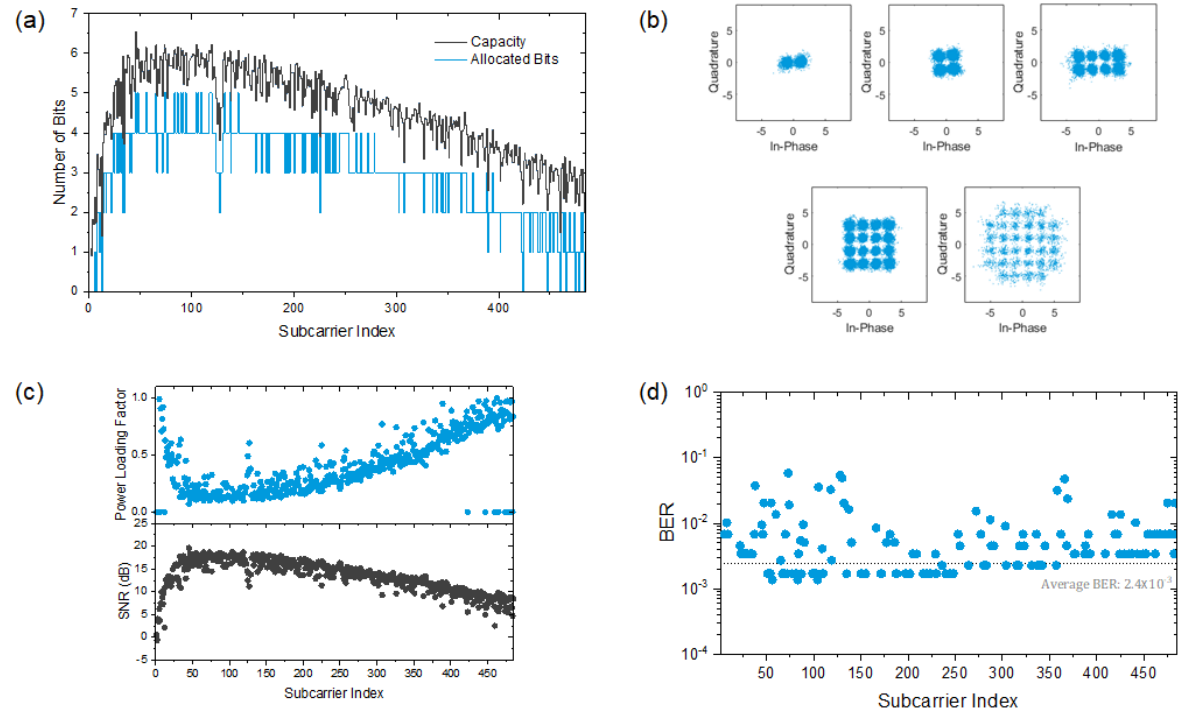
Figure 7. Communication characteristics using an OFDM modulation scheme. ( a ) Channel capacity and the bit loading scheme for all used subcarriers. ( b ) Received m-QAM constellations. ( c ) The power loading factor and the SNR for each subcarrier. ( d ) The BER for each subcarrier.